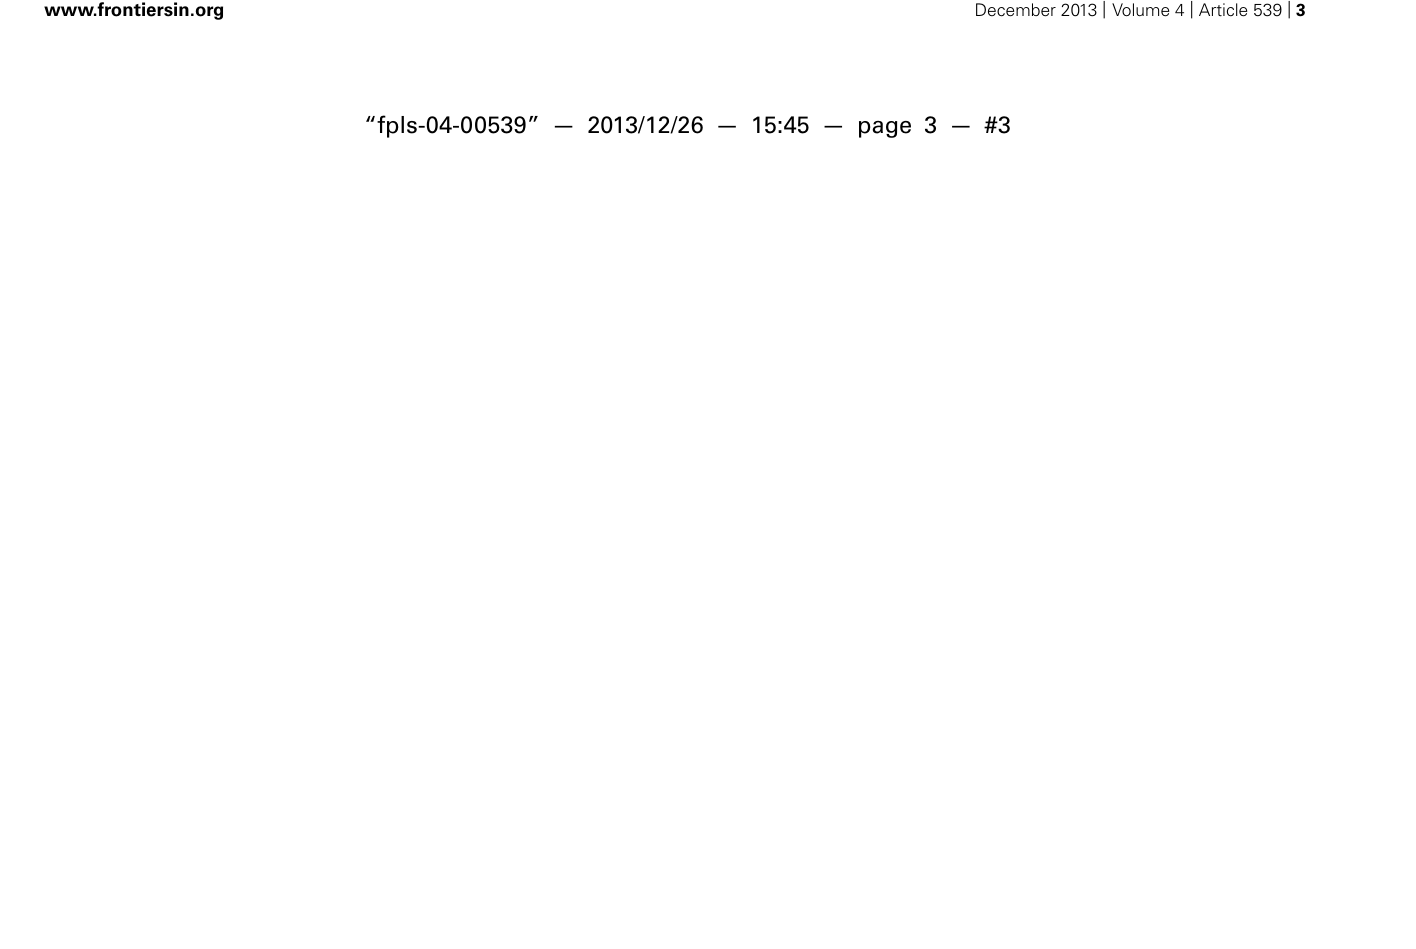
( P. rapae systemic) tissue of P. rapae -infested Col-0 and MYC2-impaired jin1-7 plants. (C) RT-qPCR analysis of ORA59 transcript levels (relative to non-infested Col-0 at 24 h) in non-infested (control) and P. rapae -damaged ( P. rapae local) and -undamaged ( P. rapae systemic) tissue of infested Col-0 and jin1-2 plants. Asterisks indicate statistically significant differences between genotypes at specific time points (** P < 0.01; *** P < 0.001) and different letters indicate statistically significant differences between treatments within one genotype at specific time points ( P < 0.05; NS, not significant). Data were analyzed per time point using two-way